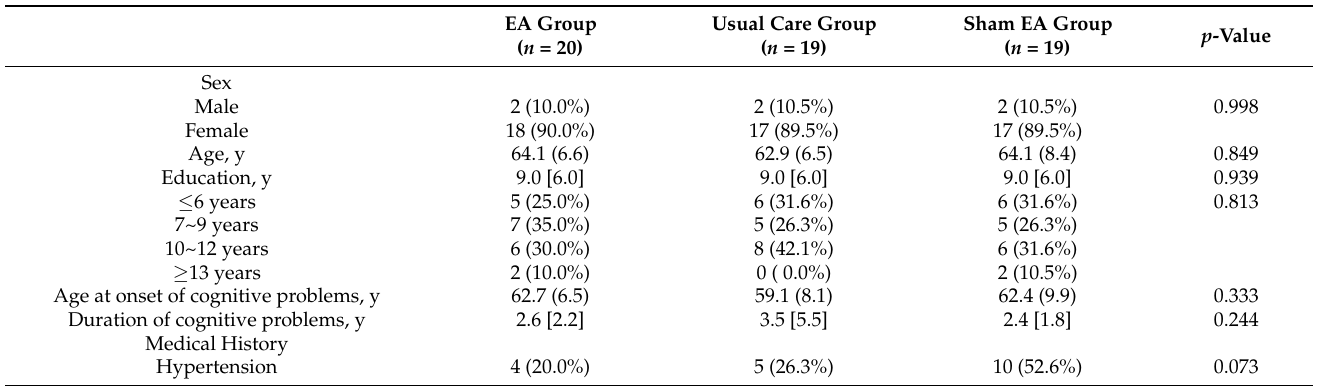
Table 1. Baseline Characteristics of